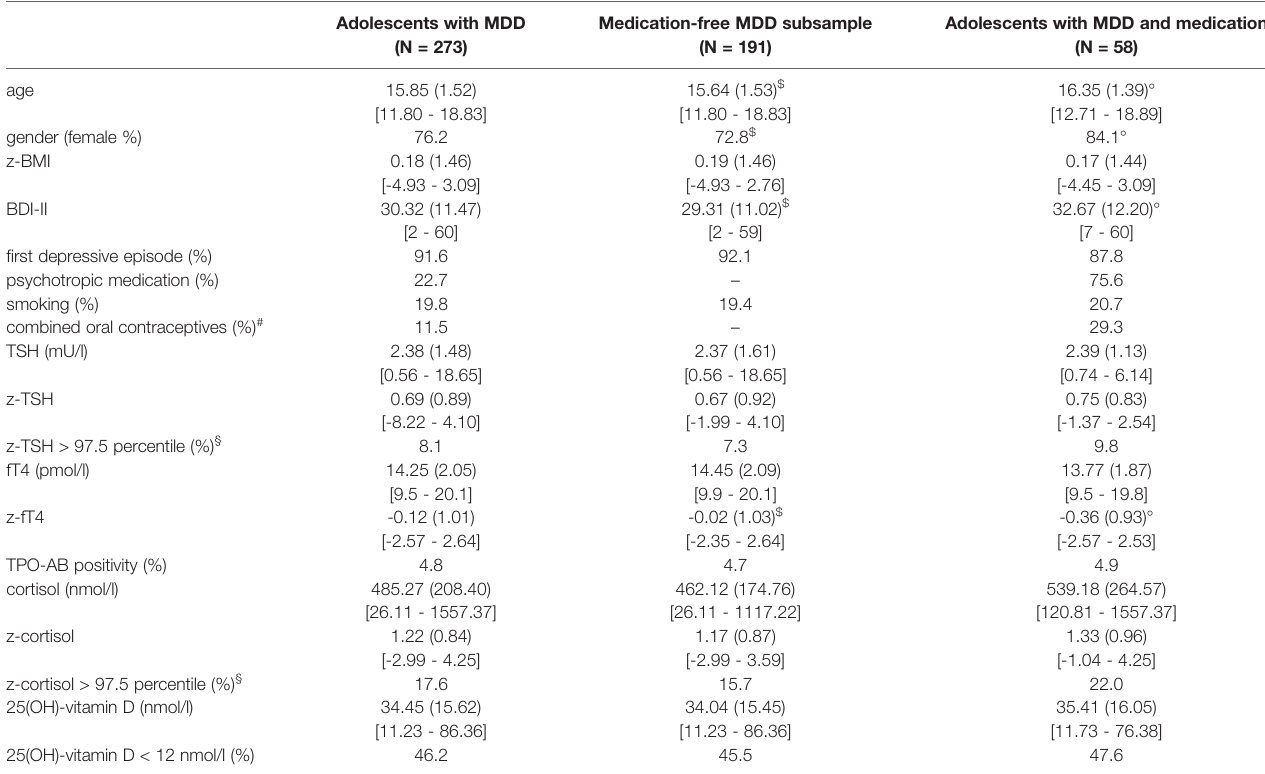
TABLE 3 | Patient characteristics.